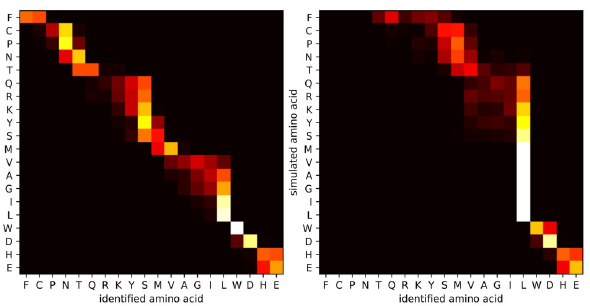
Fig 5. Heatmaps for isolated amino acid identification for SNR values 5 and 2. A heatmap for SNR 10 is shown in Fig 4. (left) With an SNR of 5, the average identification accuracy is 33.80%. With 4 clusters (FCPNTQRKYSMV, AGIL, WD, HE) the cluster identification accuracy is > 95%. (right) With an SNR of 2, the average identification accuracy is 18.60%. With 3 clusters (FCPNTQRKYSMVAGIL, WD, HE), the cluster identification accuracy is > 95%. Sequencing simulations were done for the carboxyl terminal group, at pH 3.0, for 100 ms measurement time per terminal amino acid. https://doi.org/10.1371/journal.pone.0238625.g005 Fig 6 contains heatmaps for measurement times of 1000 ms and 10 ms per amino acid, respectively. These figures confirm that longer measurement times lead to higher accuracies: they allow more samples to be taken from the signal, and more samples lead to better estimates of the average on-time. With a sufficiently long measurement time per amino acid, many small clusters of amino acids can be reliably discerned. In particular, with 10 ms measurement time, the identification accuracy is 32.94% and only 3 clusters can be discerned, while with 1000 ms measurement time, the identification accuracy increases to 79.50%, and the number of discernable clusters increases to 11. This demonstrates that the ability of the method to con- trol the measurement time is a significant advantage. Heatmaps for different pH values are shown in Fig 7. While the difference in average identi- fication accuracy is rather small, there is a clear effect on the reliable identification of specific amino acids. These heatmaps show how pH can affect the identification rate. At low pH (1.0), amino acids with a low pKa value can be more reliably discerned, whereas at a relatively high pH (4.0), it is more easy to discriminate between amino acids with a high pKa value. In general, the pKa values can be estimated more precisely when the pH value is close to the pKa value and the carboxyl group spends roughly half of the time in either protonated or deprotonated